Question: Which kind of chart has been used to present this data?
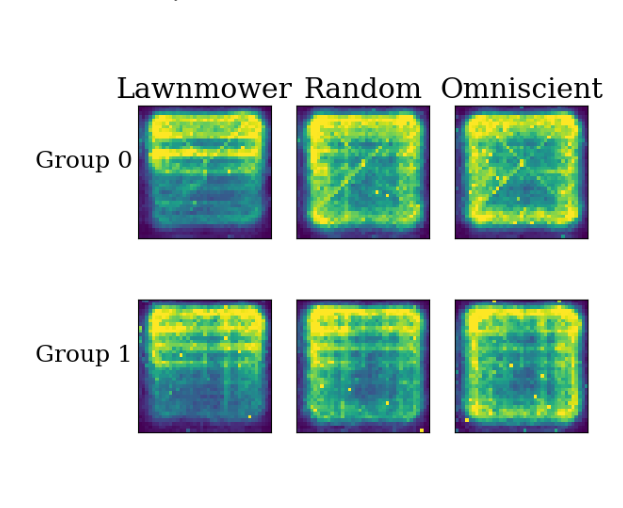
Answer: heatmap